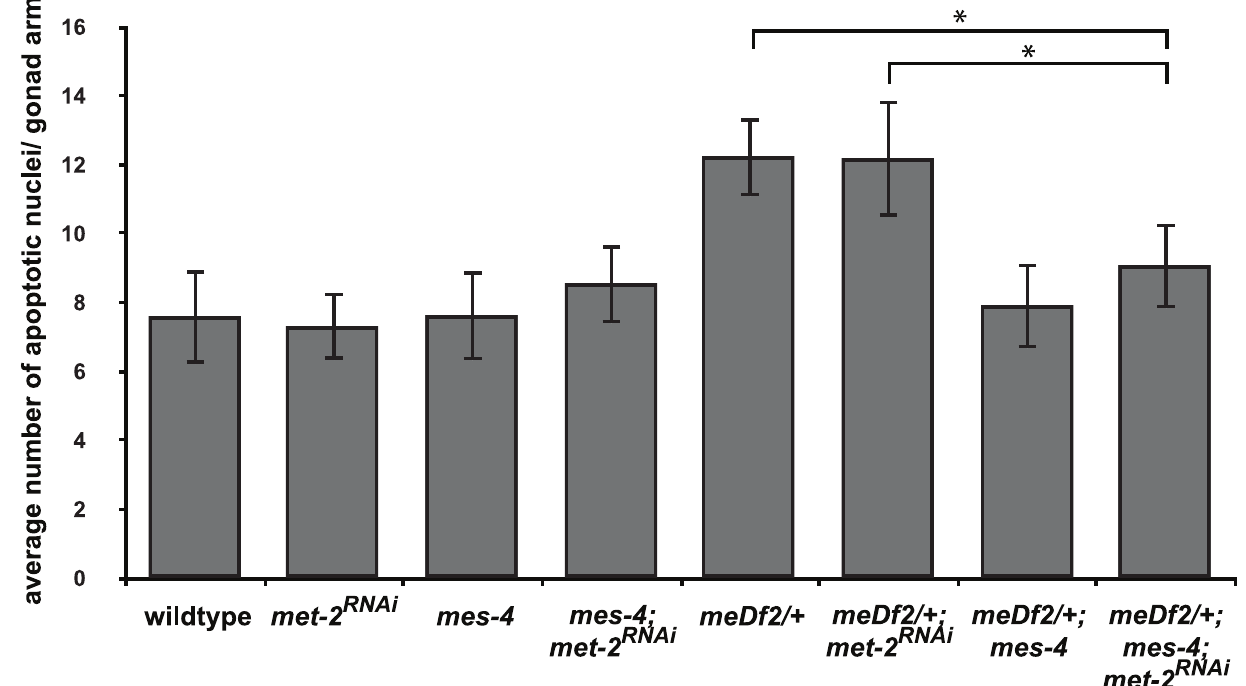
Figure 6. mes-4 ’s role in the synapsis checkpoint is independent of met-2 mediated heterochromatin assembly on unsynapsed X chromosomes. meDf2/ + ; mes-4 double mutants have nearly wild-type levels of apoptosis when met-2 is inactivated by RNA interference. A * indicates a p value of , 0.05. Error bars indicate 2XSEM.